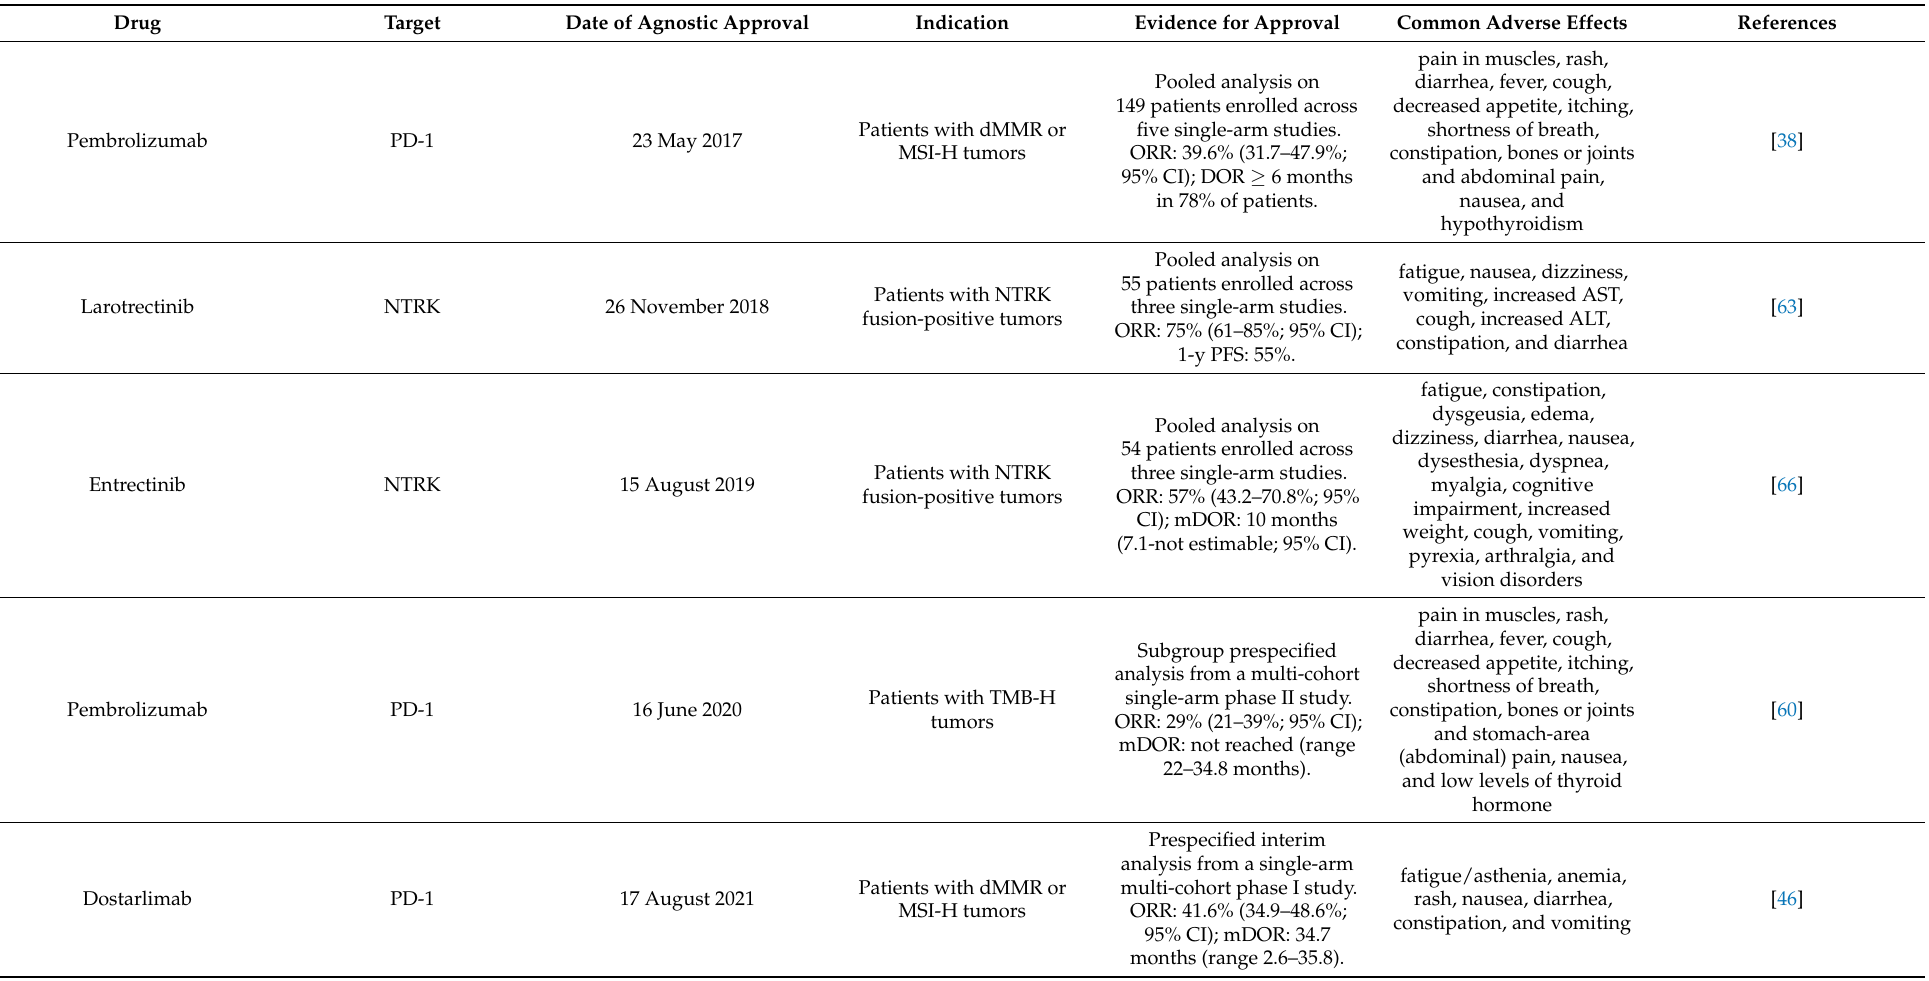
Table 1. Drugs that have already received tumor-agnostic FDA